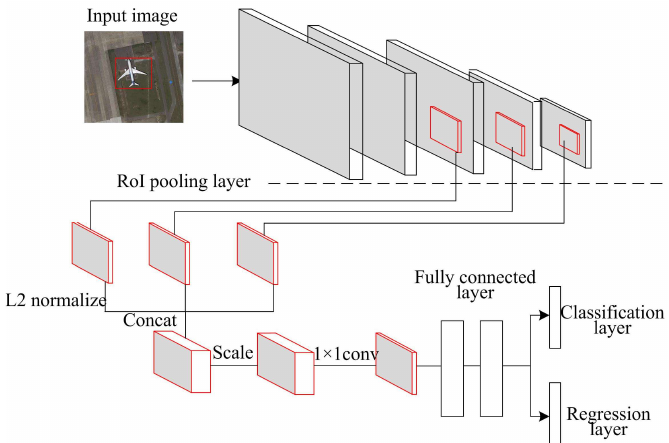
Figure 7. The structure of feature fusion.